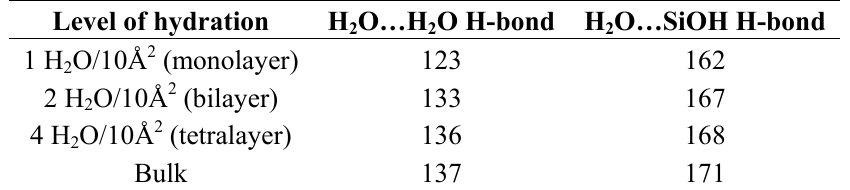
Table 1. Persistence (in fs) of H of surface concentration of